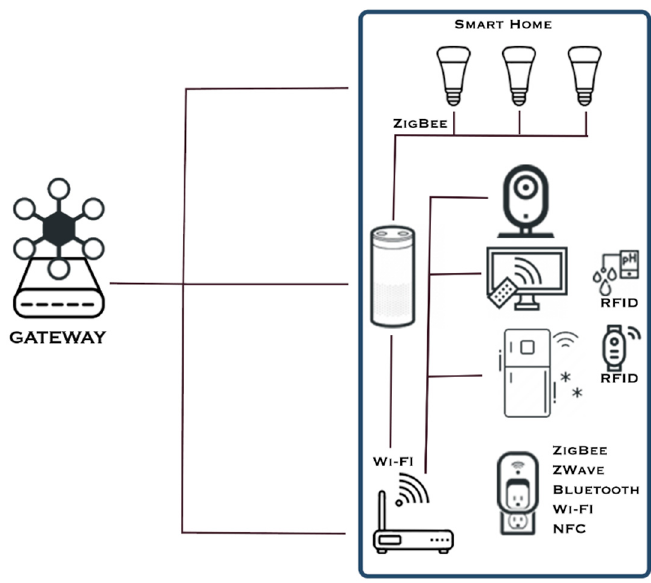
Figure 7. The data flow in the context of the gateway in a smart home environment (based on the architecture presented in Reference [31]).